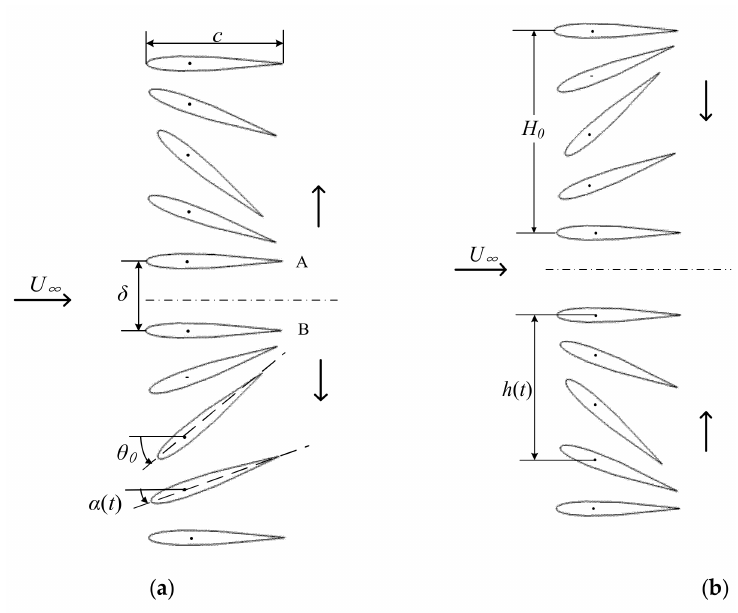
Figure 1. The structure and oscillation process of parallel foils: ( a ) t/T = 0–0.5; ( b ) t/T =